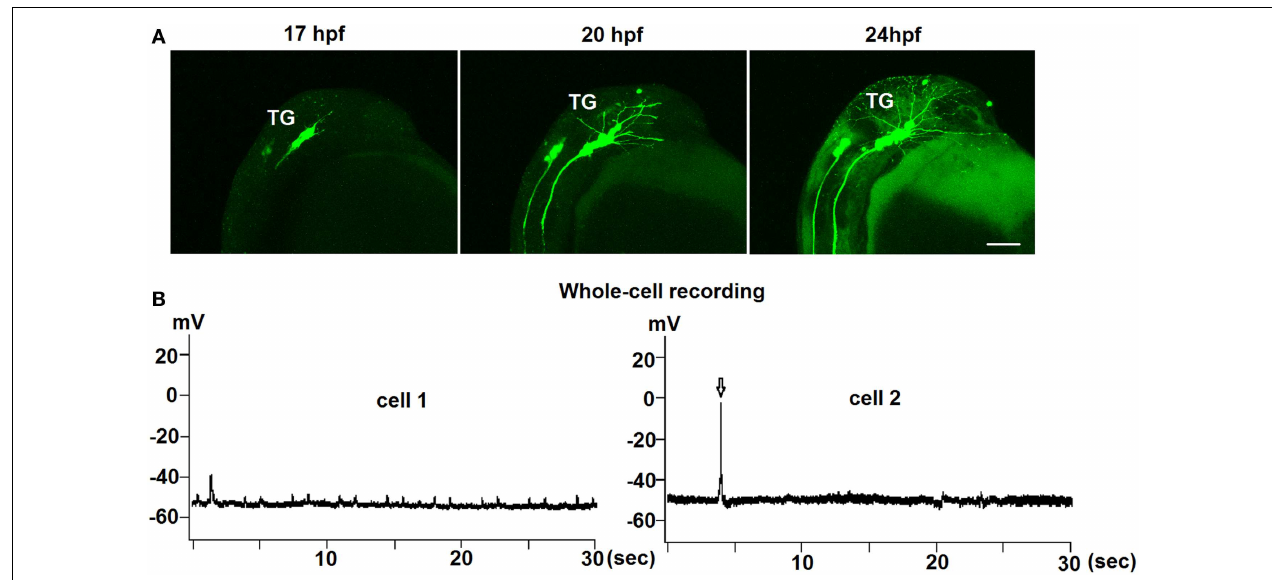
100 µ m. (B) Sample traces of whole-cell electrophysiological recording from trigeminal GnRH3 neurons at 24 hpf (cell 1) and 27 hpf (cell 2). Arrow in the bottom panel shows an action